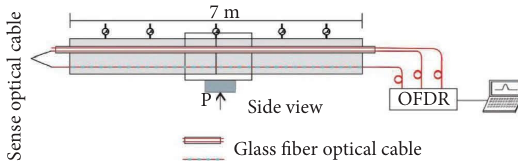
Figure 4: Layout of optical cable on the surface of CPCSP. Table 2: Main performance of measurement instrument.